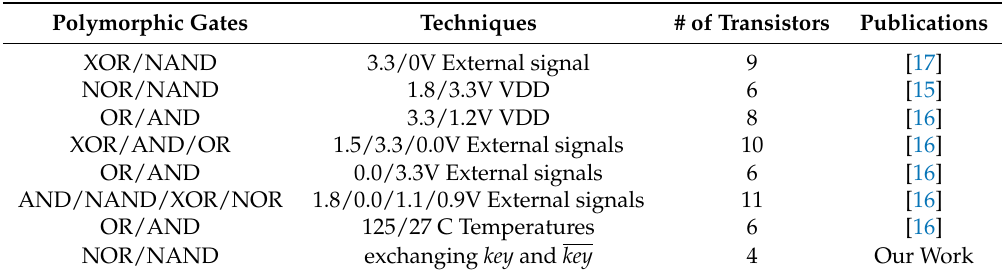
Table 1. A summary of developed polymorphic